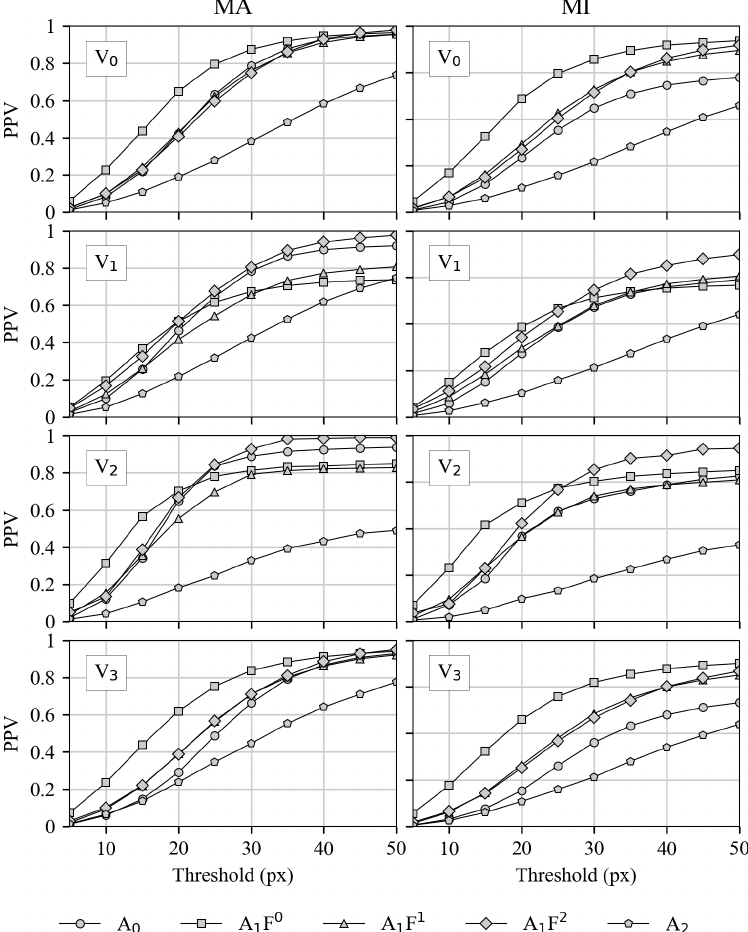
Figure 6. Precisions for all investigated HPE-CNNs and videos at different thresholds with both matching variants. Detections with all labels (MA) are shown on the left, where MI is shown on the right. In rows, results for the four different videos are presented from top ( V 0 ) to bottom ( V 3